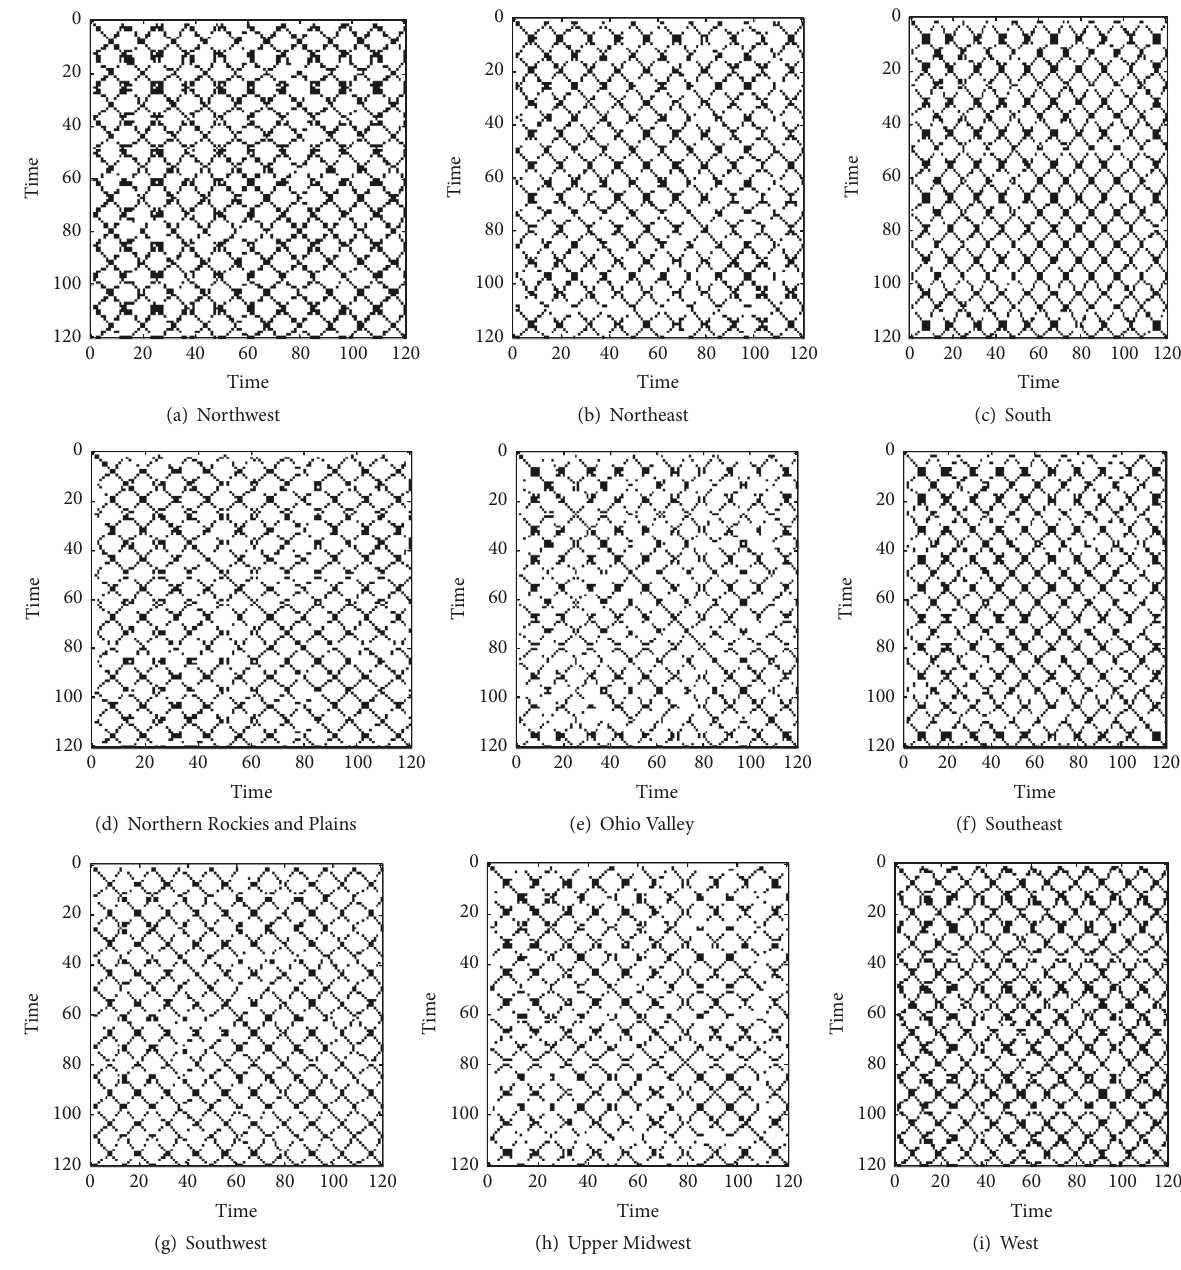
Figure 10: Recurrence plots for US